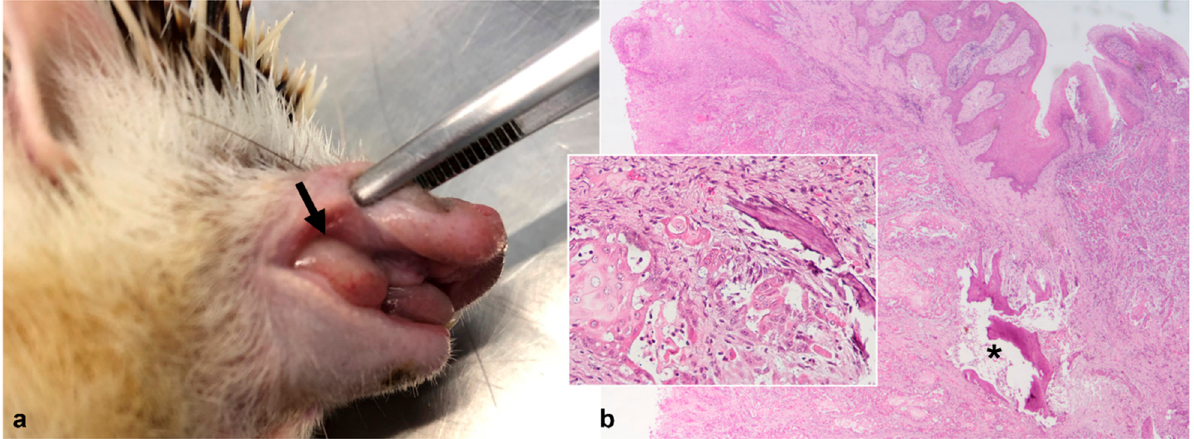
Figure 3. African pygmy hedgehog, oral cavity. Case 2, Squamous cell carcinoma. ( a ) Gross appearance of the oral mass in the right maxilla (arrow); ( b ) The mass consists of neoplastic squamous epithelial cells organized in nests. The neoplastic lesion infiltrates the underlying layers, including bone (*; HE, 20 × ). Inset: note the bone invasion by neoplastic cells and osteolysis (HE, 200 ×